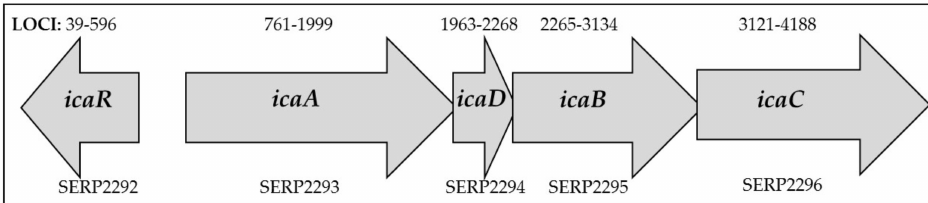
Figure 2. The arrangement of the ica operon in S. epidermidis with ordered locus names [11]. In the PIA-dependent model of biofilm production, polysaccharide intercellular ad- hesin is formed from the translation products of genes contained in the ica locus— icaADBC operon, which is responsible for biosynthesis, and the icaR gene, which is related to regula- tion. In the anaerobic environment of biofilm, expression of these genes is enhanced, inter alia, by the SrrAB (staphylococcal respiratory response regulator) protein [7,8,12,13]. PIA expression can be inhibited by the transcriptional regulator TcaR (teicoplanin-associated locus regulator), Spx (a global regulator of the stress response genes) and IcaR protein, as well as by integration into the genes of the ica operon in the IS25 insertion element